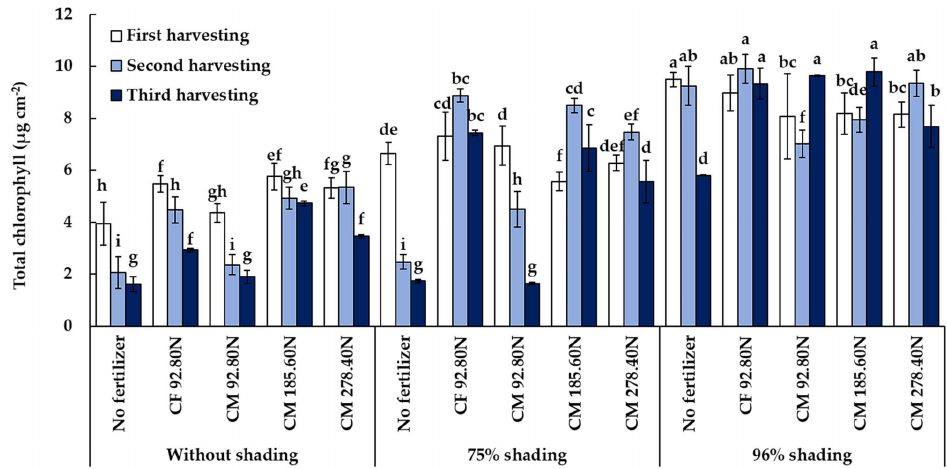
Figure 4. Total chlorophyll content in fiddleheads of vegetable fern grown under different shading and fertilizer application treatments at each harvesting time. Values are means with standard deviations ( n = 4). The different letters above the bars indicate statistically significant differences by Duncan’s multiple range tests ( p < 0.05) within each harvesting month.